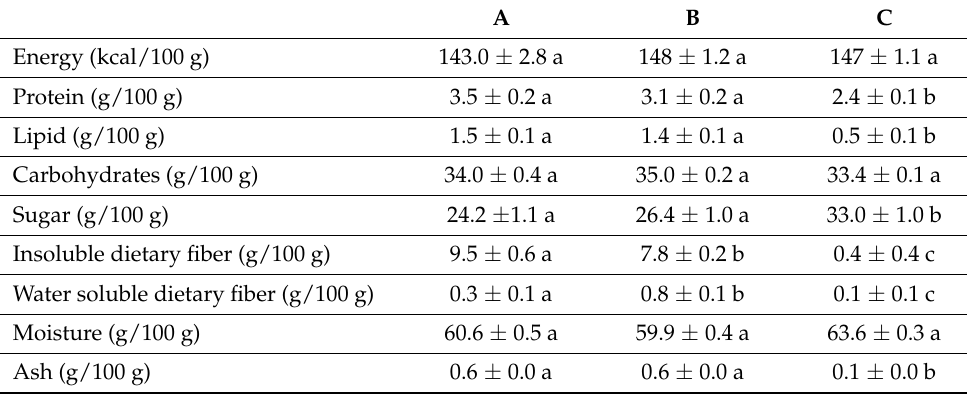
Table 3. The principal compositions of three kinds of cooked rice for the human